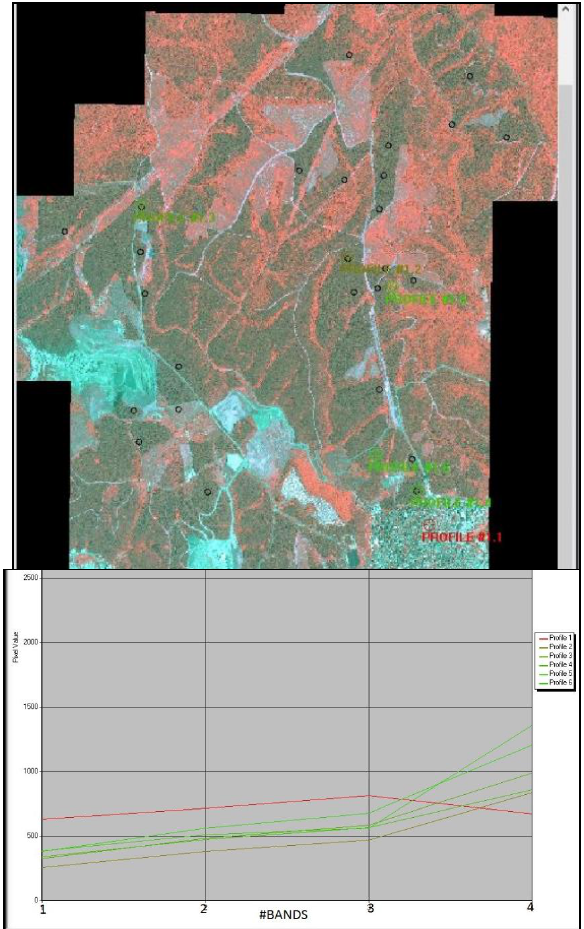
Fig. 2. Near band effect in different profile